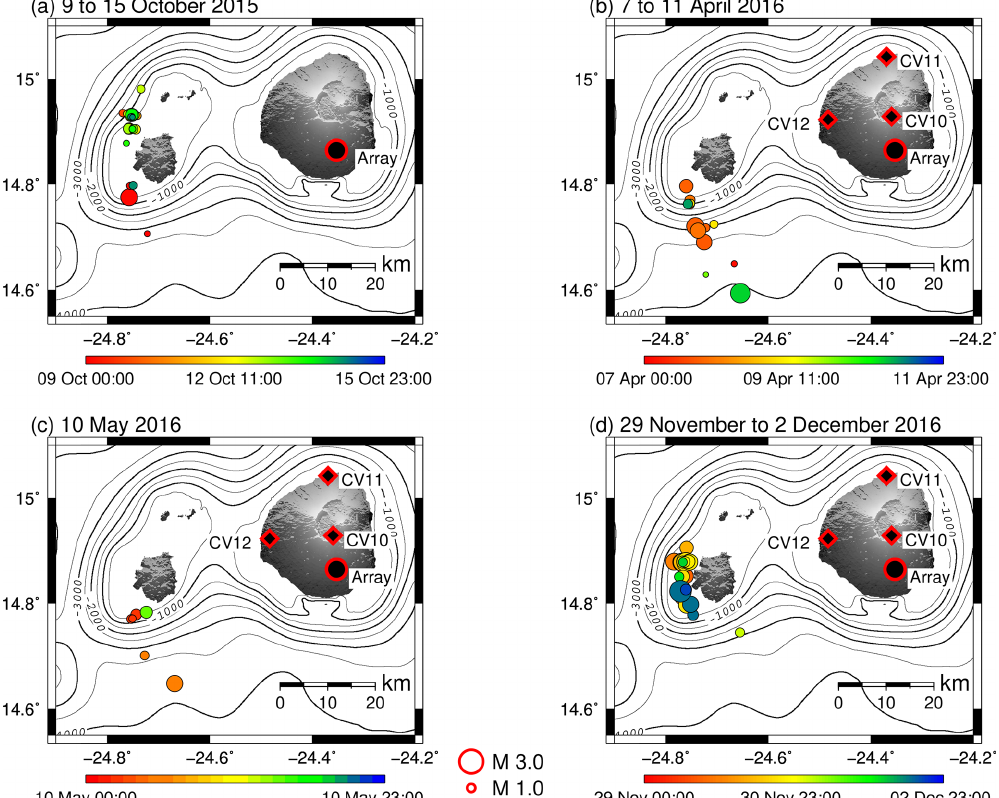
Figure 10. Earthquake locations for four different time periods of elevated seismicity: (a) 9–15 October 2015, (b) 7–11 April 2016, (c) 10 May 2016, and (d) 29 November to 2 December 2016. Red/black circle: position of the array, red/black diamonds: additional broad- band stations on Fogo. Topographic and bathymetry data are from Ryan et al.